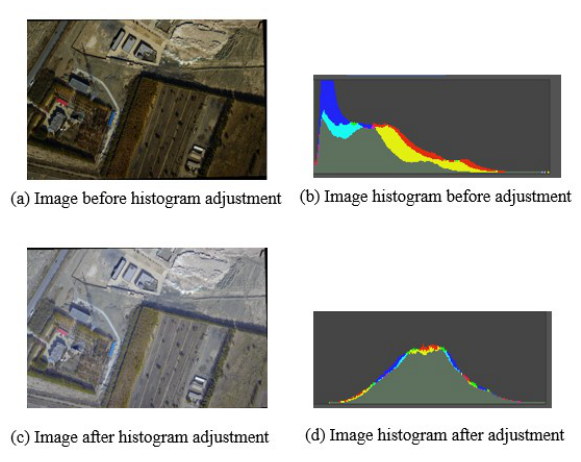
Figure 3 . Histogram adaptive adjustment.